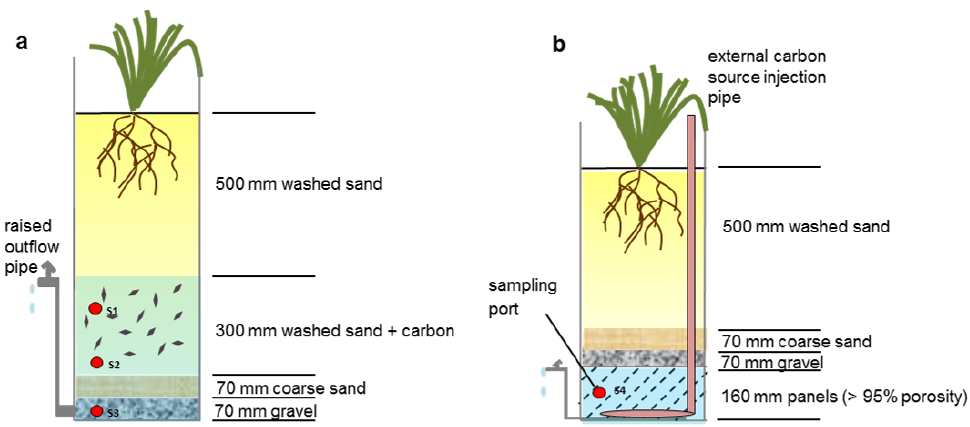
Figure 1. Laboratory biofilter configuration: ( a ) standard saturated zone design; ( b ) novel saturated zone (NSZ) design.